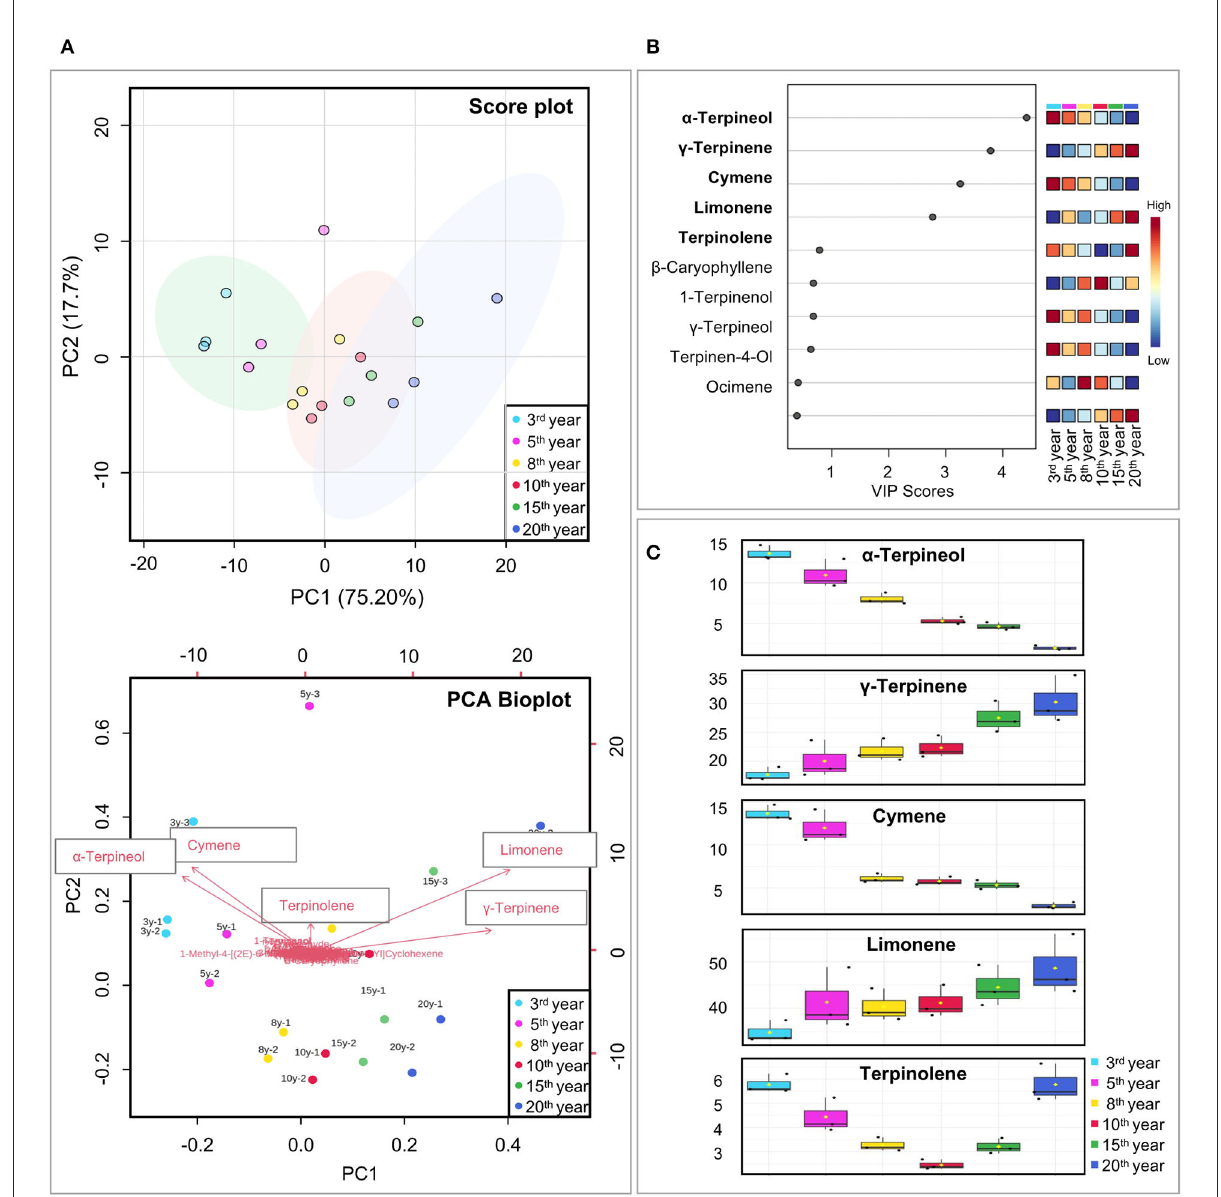
FIGURE3 Selection of volatile markers for Laoxianghuang in six different fermentation years. (A) 2D score plot of PCA for PC1 and PC2 (above) and their biplot (below, including the position of each sample for PC1 and PC2 and how the variables map to these samples). Sample replicates are shown by the small circles of the same color. (B) VIP of PLS-DA score plots. A VIP score greater than 1 of the compound was considered to indicate differential volatility. (C) Relative content of candidate markers selected by PCA and